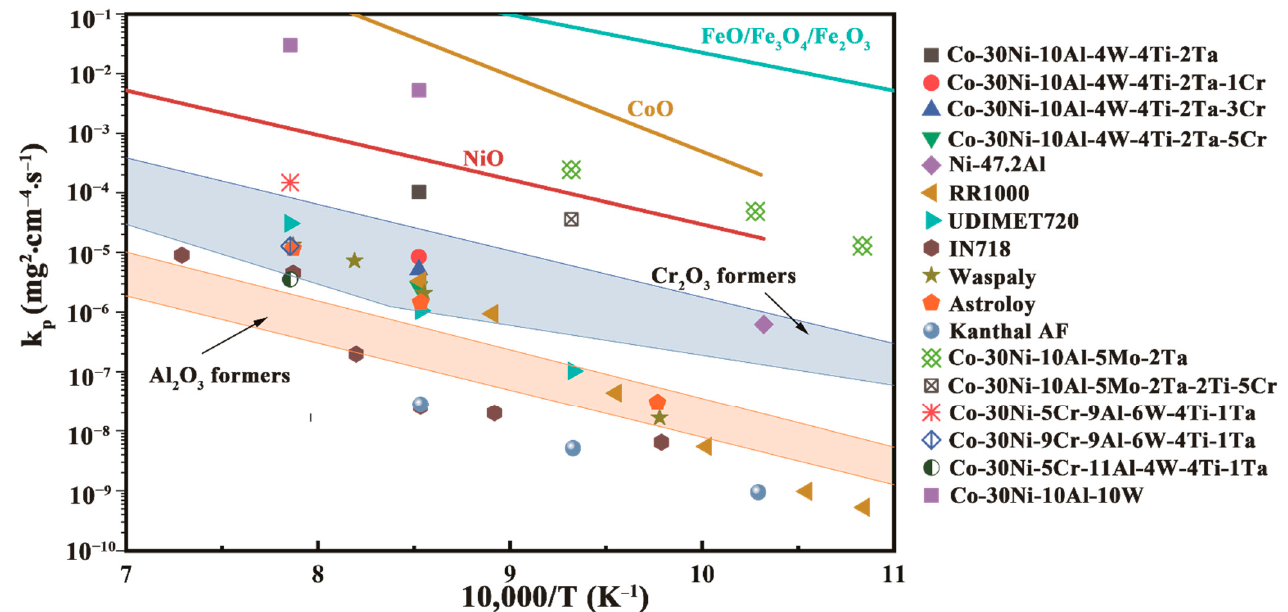
Figure 12. Parabolic rate constants versus reciprocal temperature for some Ni- and Co-based alloys from the literature and the values determined in this study [15,23,35]. The shaded areas represent the typical values of chromium and alumina formers. Adapted from Refs [19,36].